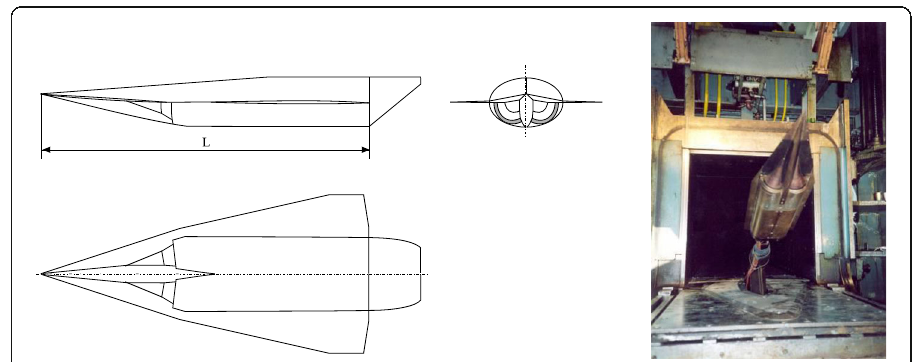
Fig. 4 Configuration of high-speed vehicle based on waverider